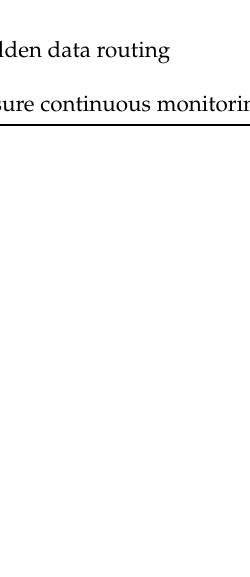
Table 8. A summary of the suggested guidelines for data at rest layer along with their